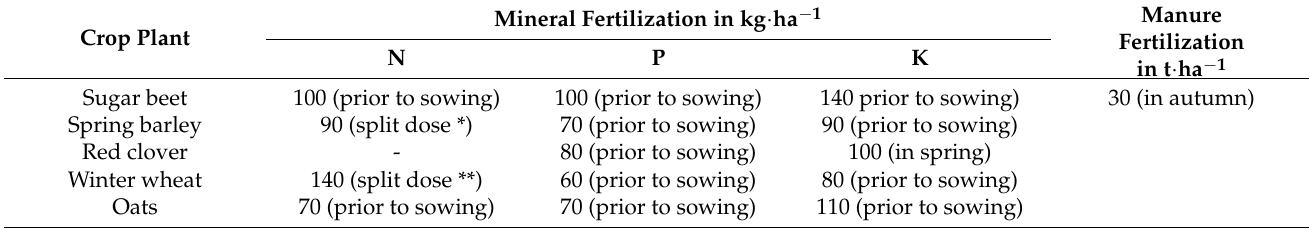
Table 2. Fertilization used in the conventional system.